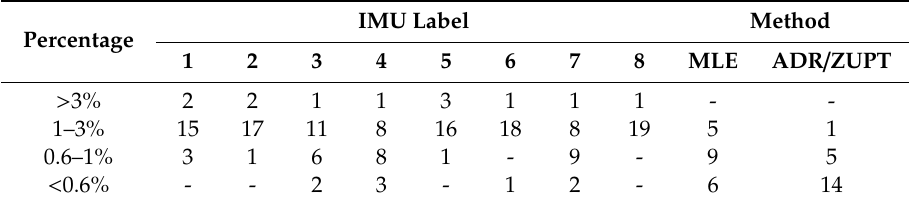
Table 2. Numbers of closed-loop experiments with di ff erent error